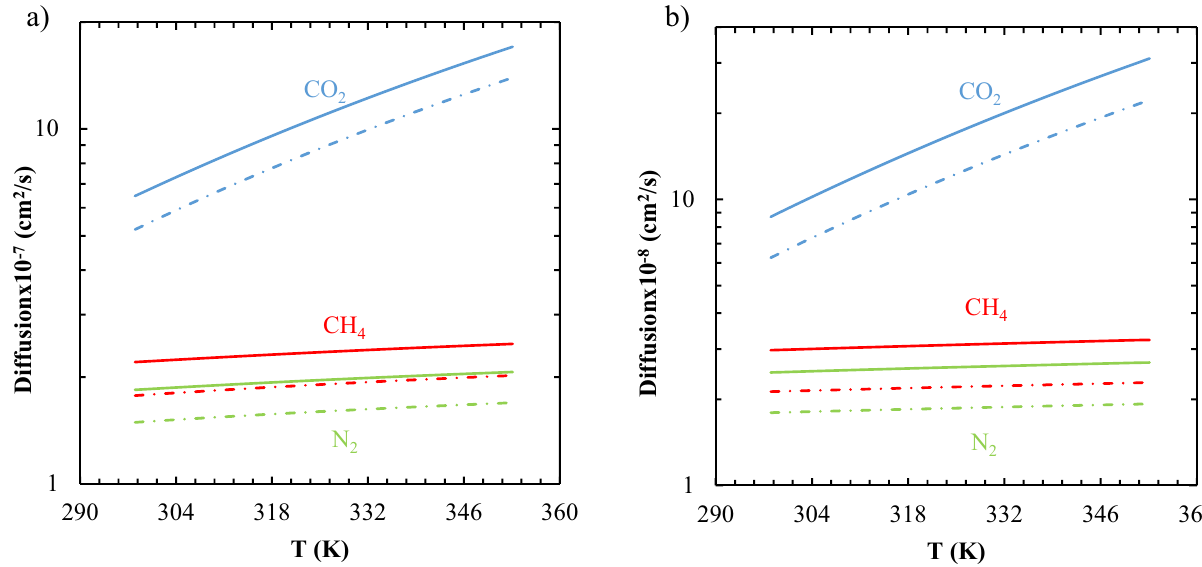
Figure 8. The prediction of the gas diffusion coefficients at p = 0.1 MPa based on the modeling (lines) and viscoelastic parameters of the DMTA analysis (dashed lines): ( a ) TPU-1, and ( b )